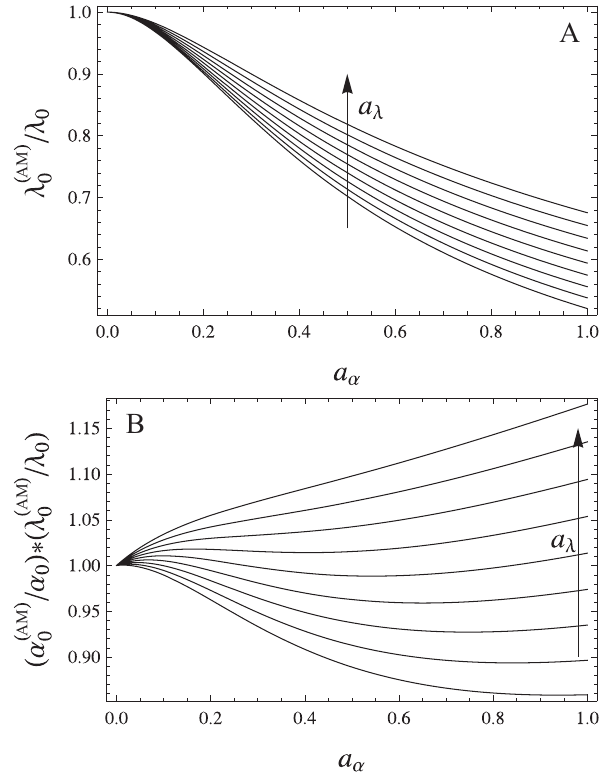
Fig. 7. Panel (A) Sensitivity of the λ ( AM ) to λ 0 ratio to 0 varying a α and a λ values (with T =100 years, δ =0, n =1 and λ 0 =20 events/year). Panel (B) Sensitivity of the non-dimensional α ( AM ) /λ 0 α 0 to the same parameter product λ ( AM ) 0 0